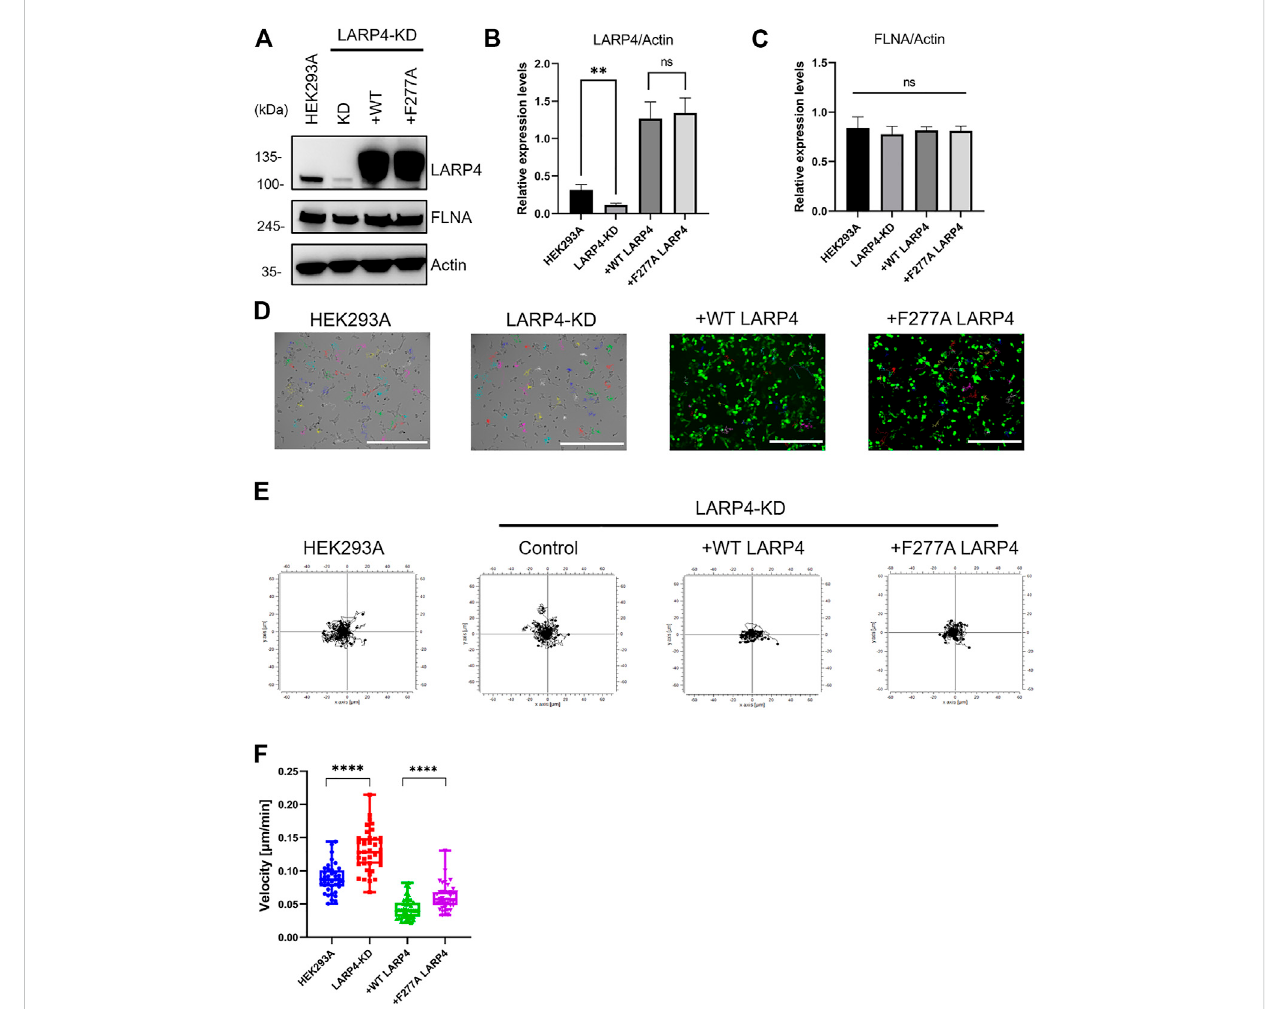
FIGURE 8 Interaction of FLNA and LARP4 inhibits cell migration. LARP4-KD HEK293A cells were transfected with GFP WT LARP4 and F277A LARP4. (A) . Western blotanalysisforLARP4 andFLNAinLARP4-KDcells24 haftertransfectionofWTandmutantGFP-LARP4. β -Actinwasusedasaloadingcontrol. Relative expression level of LARP4 (B) and FLNA (C) to actin were quanti fi ed and are shown in the diagrams with their standard deviations ( n = 3). p > 0.05 wasconsidered as not signi fi cant (ns)and ** p ≤ 0.01 weredetermined bytwo-tailedunpairedStudent ’ s t -testorone-wayANOVA analysis. (D) . Images of cells were captured at 1 frame/10 min for 16 h by time-lapse microscopy and tracked the migratory paths of cells ( n = 40). Bar: 400 μ m. (E) Plots show an example tracking 40 cells from one of three independent experiments. (F) Mean migration speed ( μ m/min) of cells. Values represent